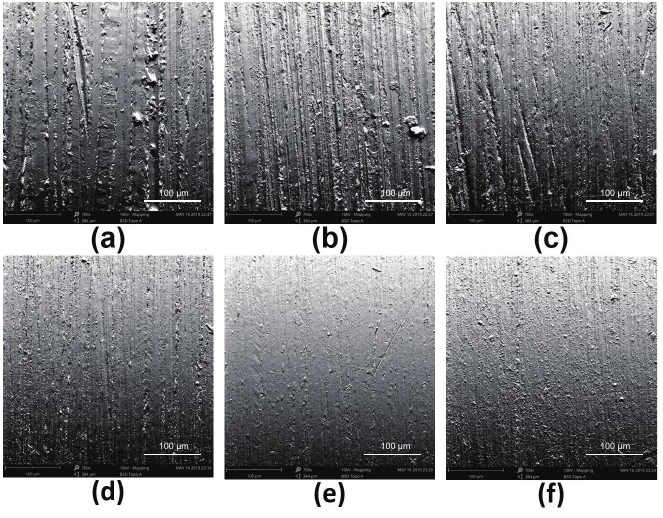
Figure 5. SEM images of brass samples surface at 700 × . The sub-figures from ( a – f ) correspond to the grit densities of 180, 400, 800, 1200, 1500 and 2000,